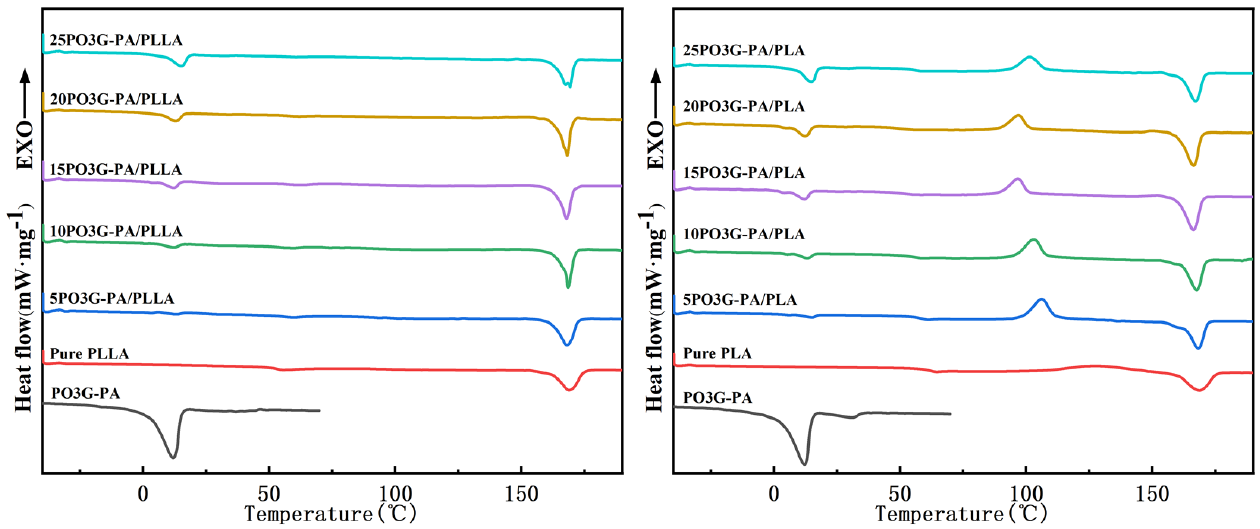
Figure 5. TG and DTG of PO3G–PA/PLLA composite films with different ratios.